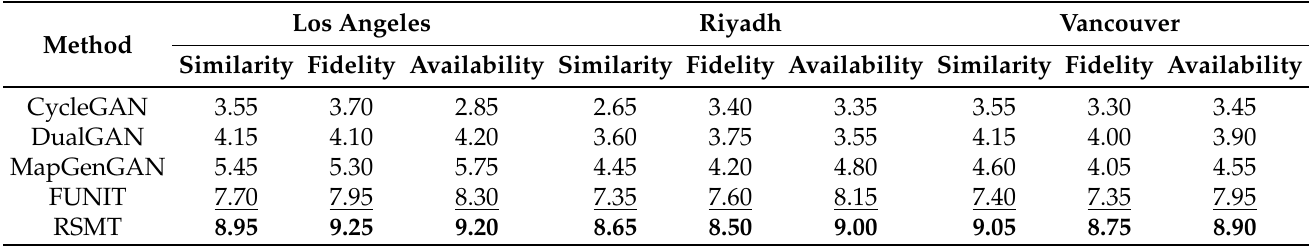
Table 2. Average scores of subjective evaluation from human perceptual for RSMT and baselines on three testing datasets. (bold: best; underline: